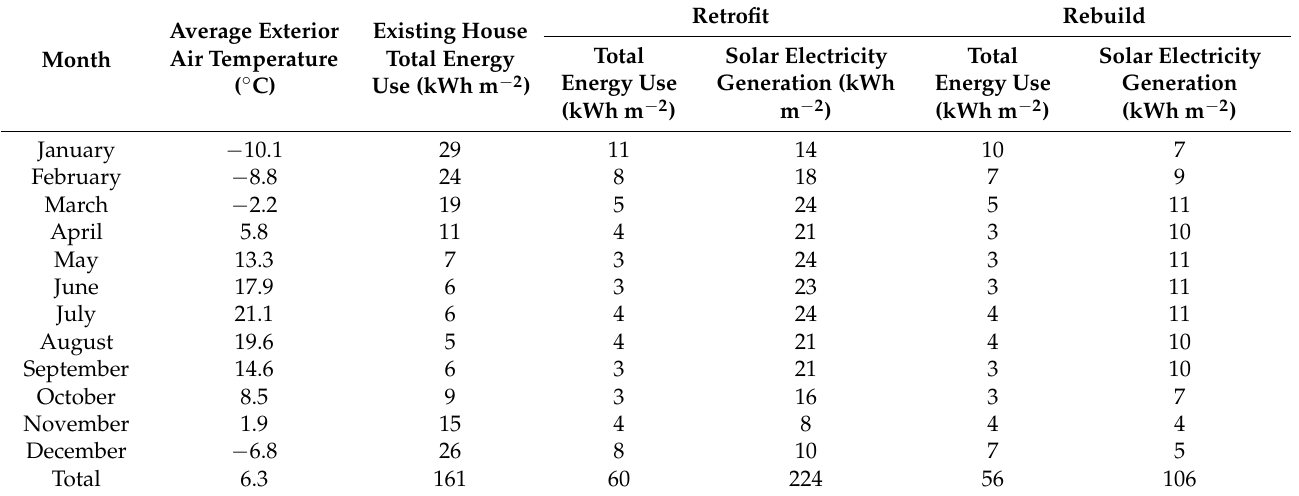
Table 1. Energy performance of the existing, retrofitted, and rebuilt houses (values are based on 140 m 2 of living area for all three houses).